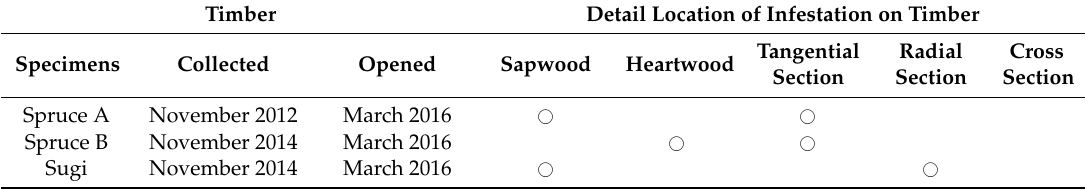
Tangential Radial Cross Section Section Section